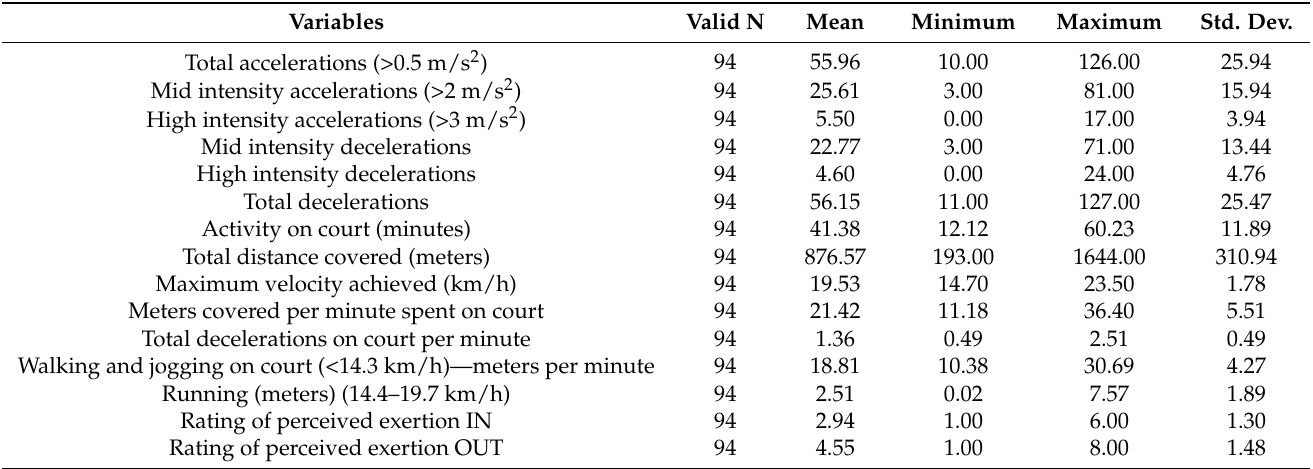
Table 2. Descriptive statistics of Ball Kid’s on-court